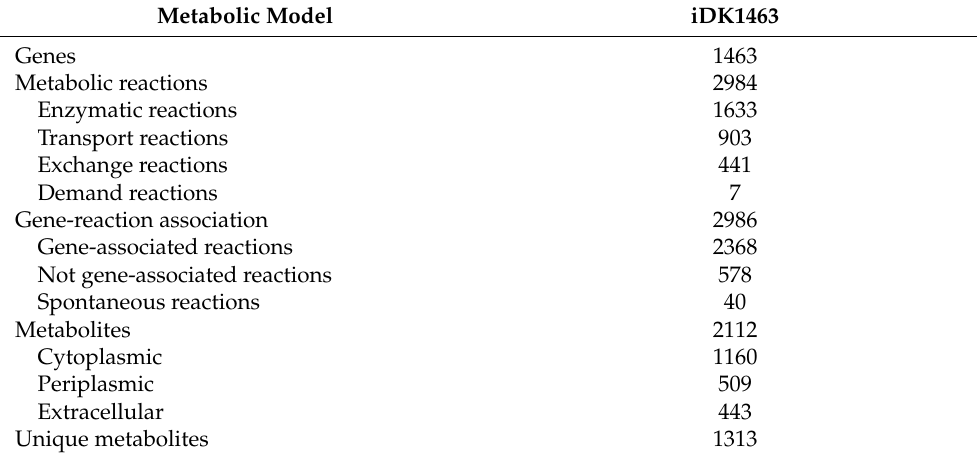
Table 2. Components of the metabolic network model of E. coli Nissle